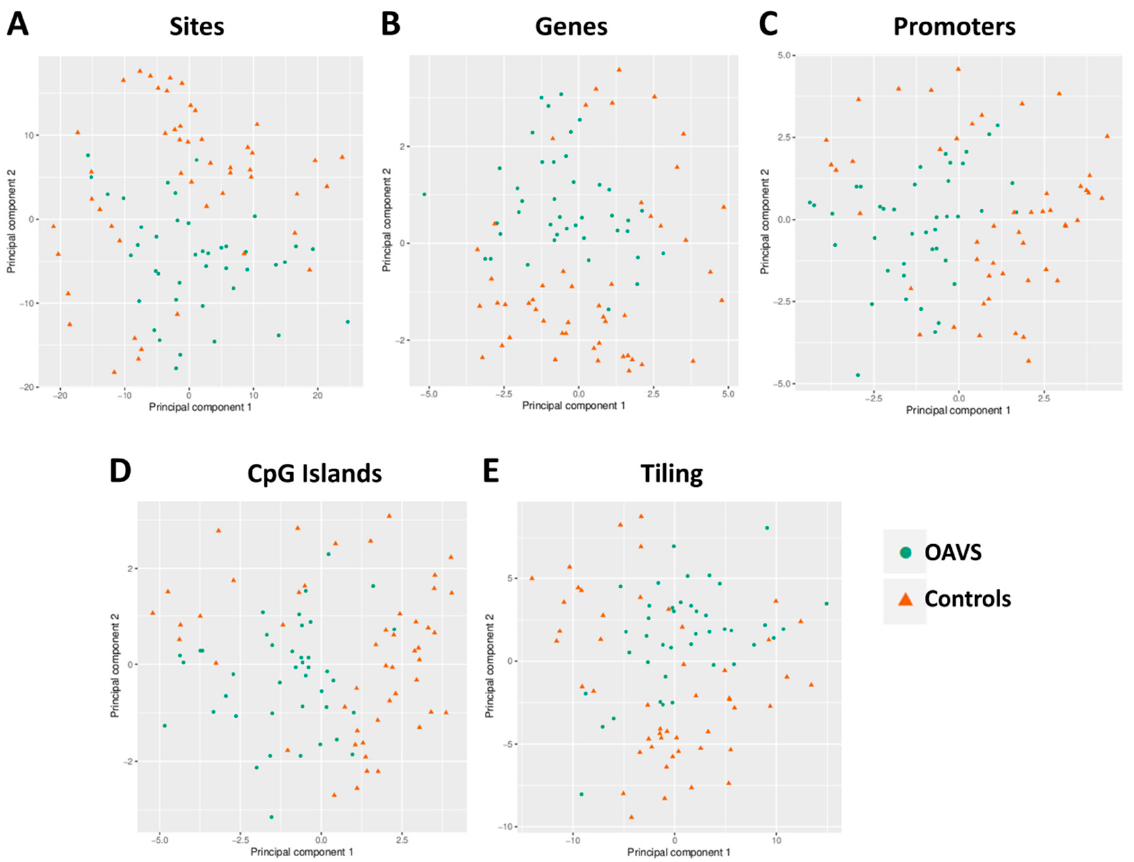
Figure 1. Scatter plot locating samples in the first two principal components at ( A ) sites, ( B ) genes, ( C ) promoters, ( D ) CpG islands, and ( E ) tiling.